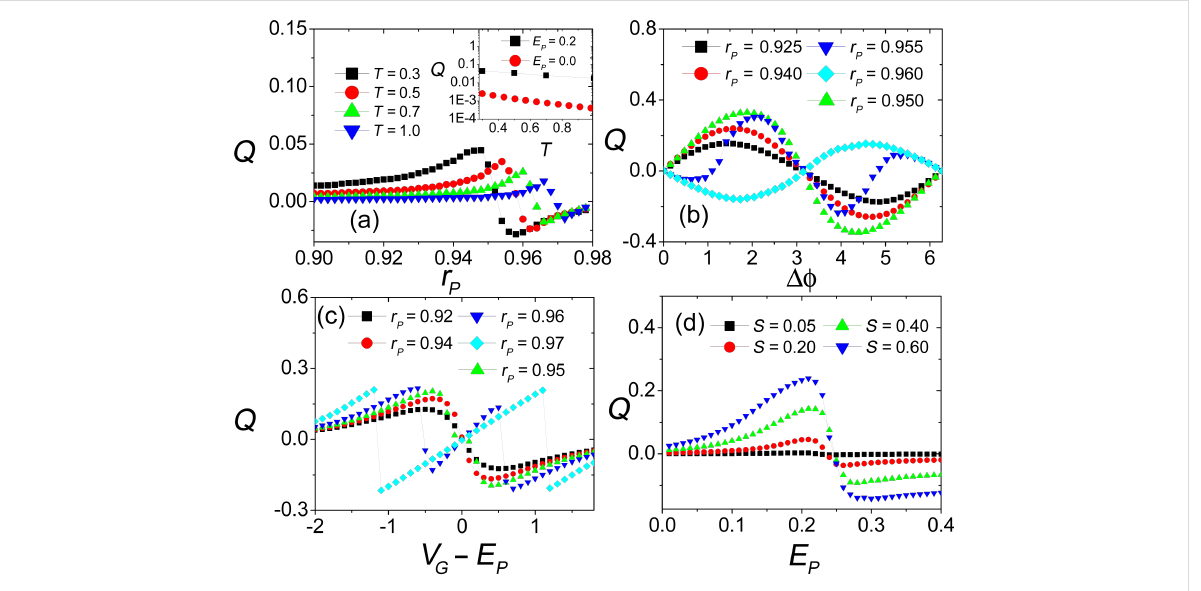
Figure 14: Electronic charge pumped in a two-parameter pumping device in the presence of an adiabatic vibrational degree of freedom. Panel (a): The pumped charge Q as a function of the external frequency for different temperatures. Inset: The value of the charge at the maximum as a function of the temperature is compared with the pumped charge for E P = 0. In this panel T = 0.3, V G = − 0.1, S = 0.20, = π /4. Panel (b): The pumped charge Q for S = 0.5 as a function of the phase difference for different values of r P . In this panel T = 0.3, V G = − 0.1, and E P = 0.2. Panel (c): The pumped charge Q as a function of V G − E P for different values of r P . In this plot T = 0.3, V G = − 0.1, E P = 0.2, S = 0.50, and = π /4. Panel (d): The pumped charge Q as a function of the electron–oscillator coupling E P for different values of the pumping strength S . In this plot T = 0.3, V G = − 0.1, r P = 0.945, and = π /4. Notice that the pumping strength S = 0.6 corresponds to the driving ratio ≈ 1.765, which is very close to the maximal value of 2. Adapted and reproduced with permission from [84], copyright 2014 IOP